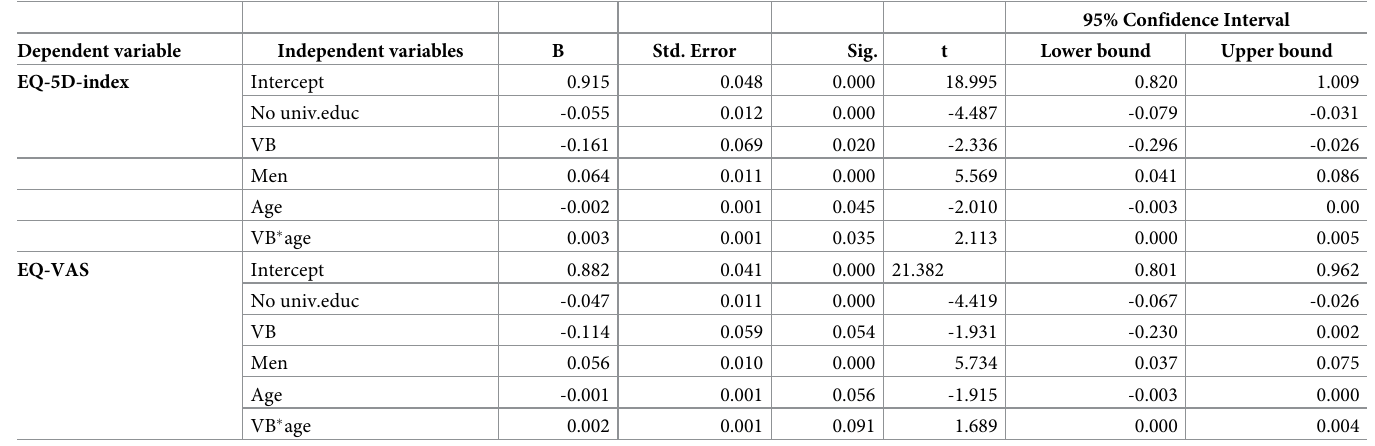
Table 5. Multivariable linear regression model with interaction term between Va¨sterbotten county and age. Dependent